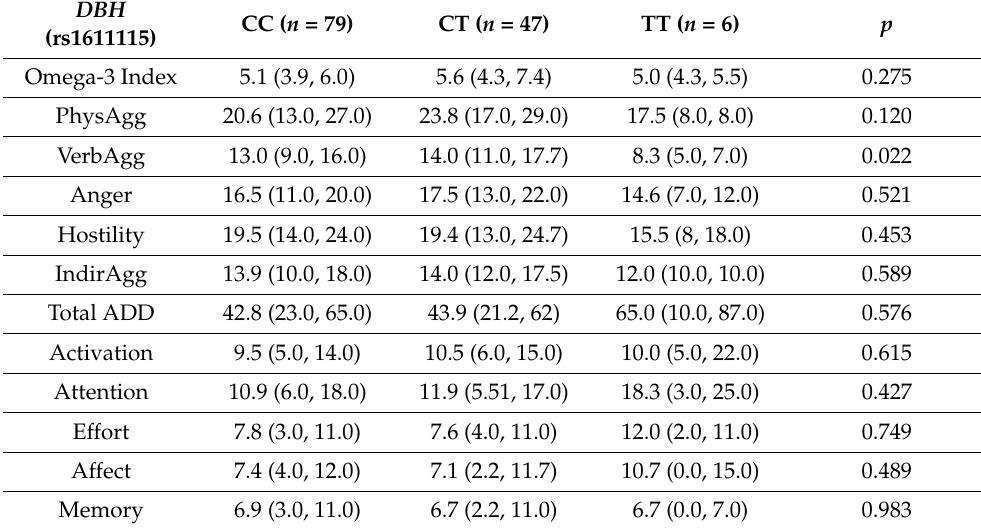
Table 4. DBH genotypes analysis according to Omega-3 Index and neuropsychological